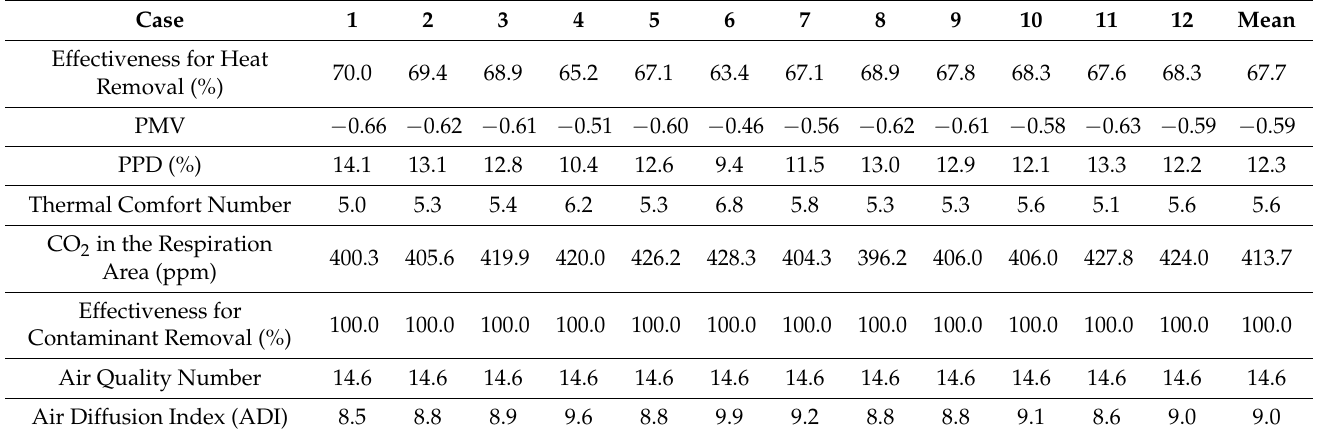
Table 15. ADI obtained for Case VI (0.2722 m 3 /s) at 10 h.